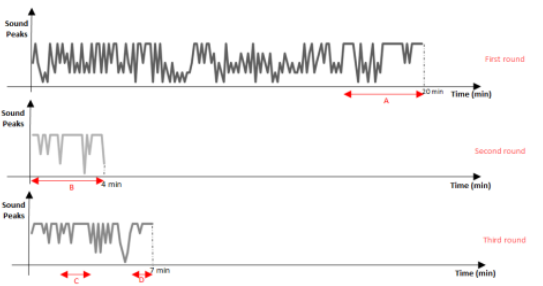
Figure 12 Students' excitement analyze based on their sound